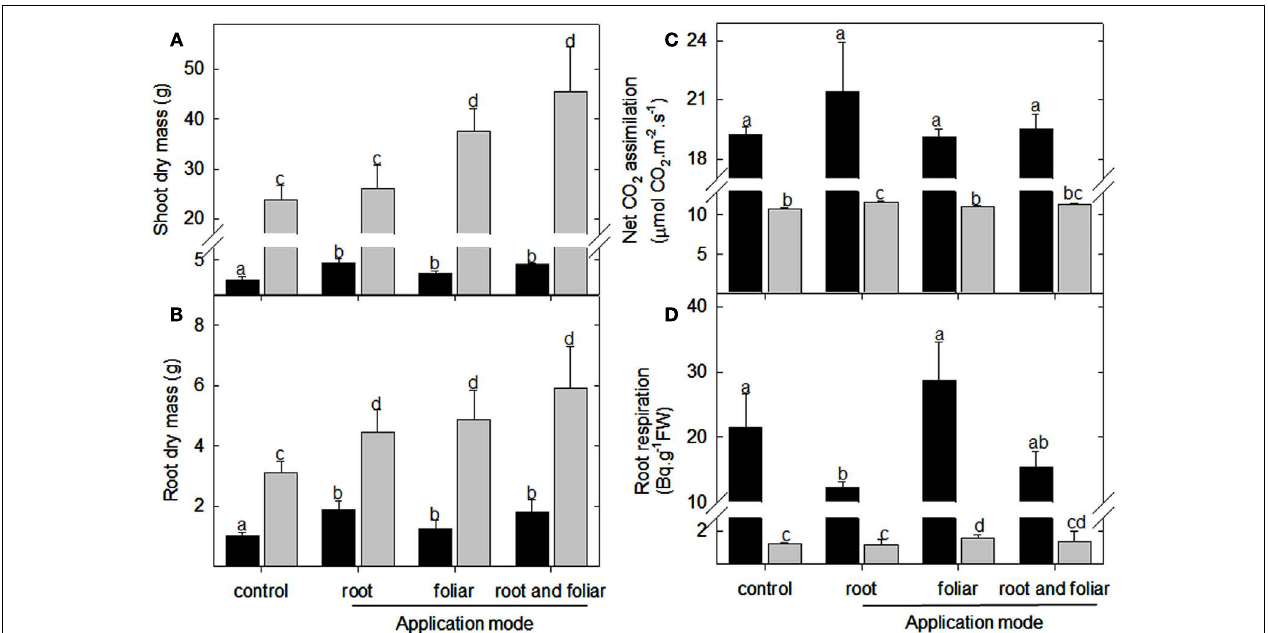
photoperiod.The values are the mean ± SE ( n = 5).The data was analyzed using one way ANOVA followed by Fisher’s least significant difference, bars that do not share letters are significantly different ( P < 0.05) from each other.The results were confirmed in at least four independent experimental